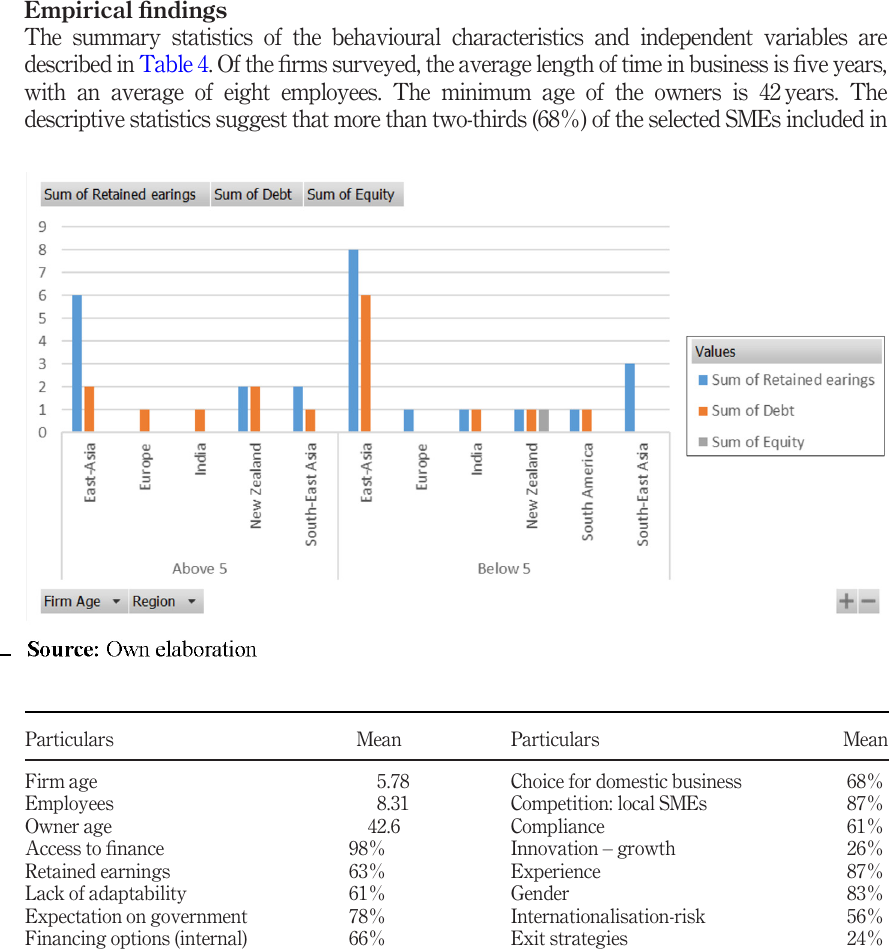
Table 4. Summary of descriptive